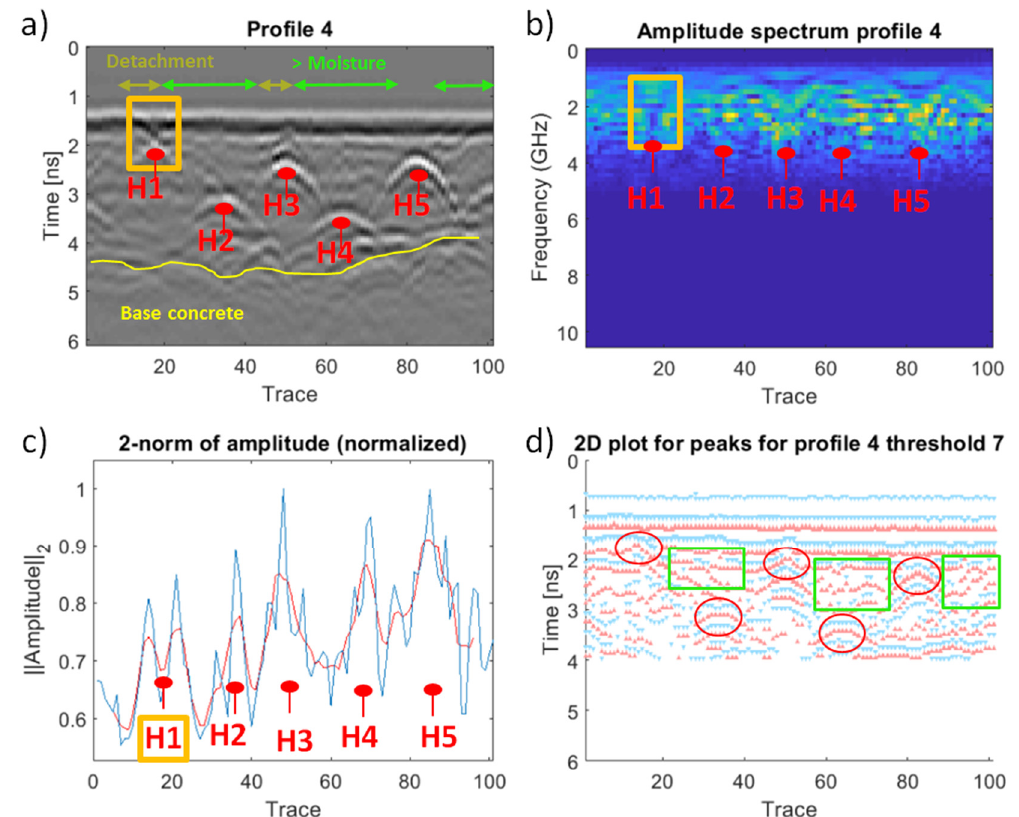
Figure 8. Graphics obtained for GPR profile 4 and interpretation. The orange rectangles in graphs ( a – c ) indicate open-air rebars, while the lawn green arrows in ( a ) correspond to moist areas and the olive-green arrows are associated to detachment. The red circles in ( d ) represent a positive polarity of the reflections produced by the rebars, while the lawn green rectangles represent a negative signal polarity associated to moist areas and the orange rectangles correspond to open-air rebars.